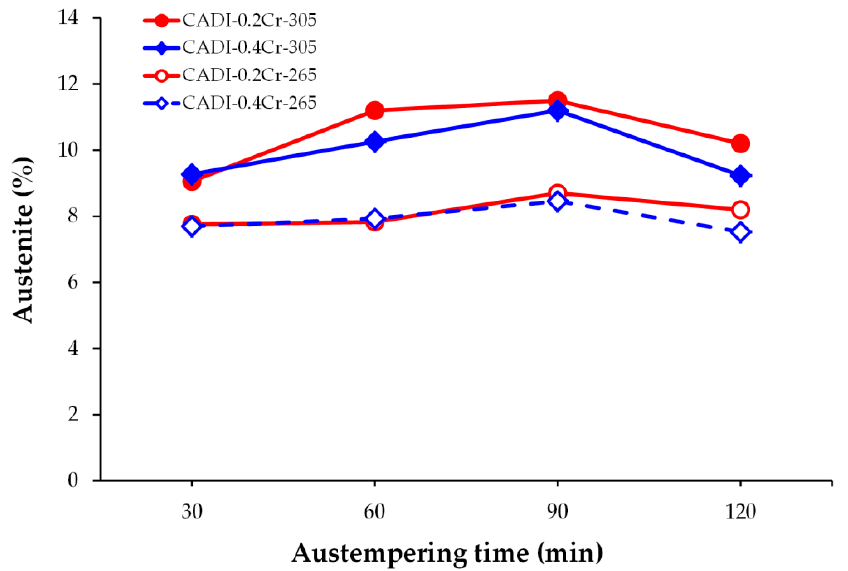
Figure 11. Effect of the austempering time and temperature on the high-carbon austenite formation for CADIs evaluated.